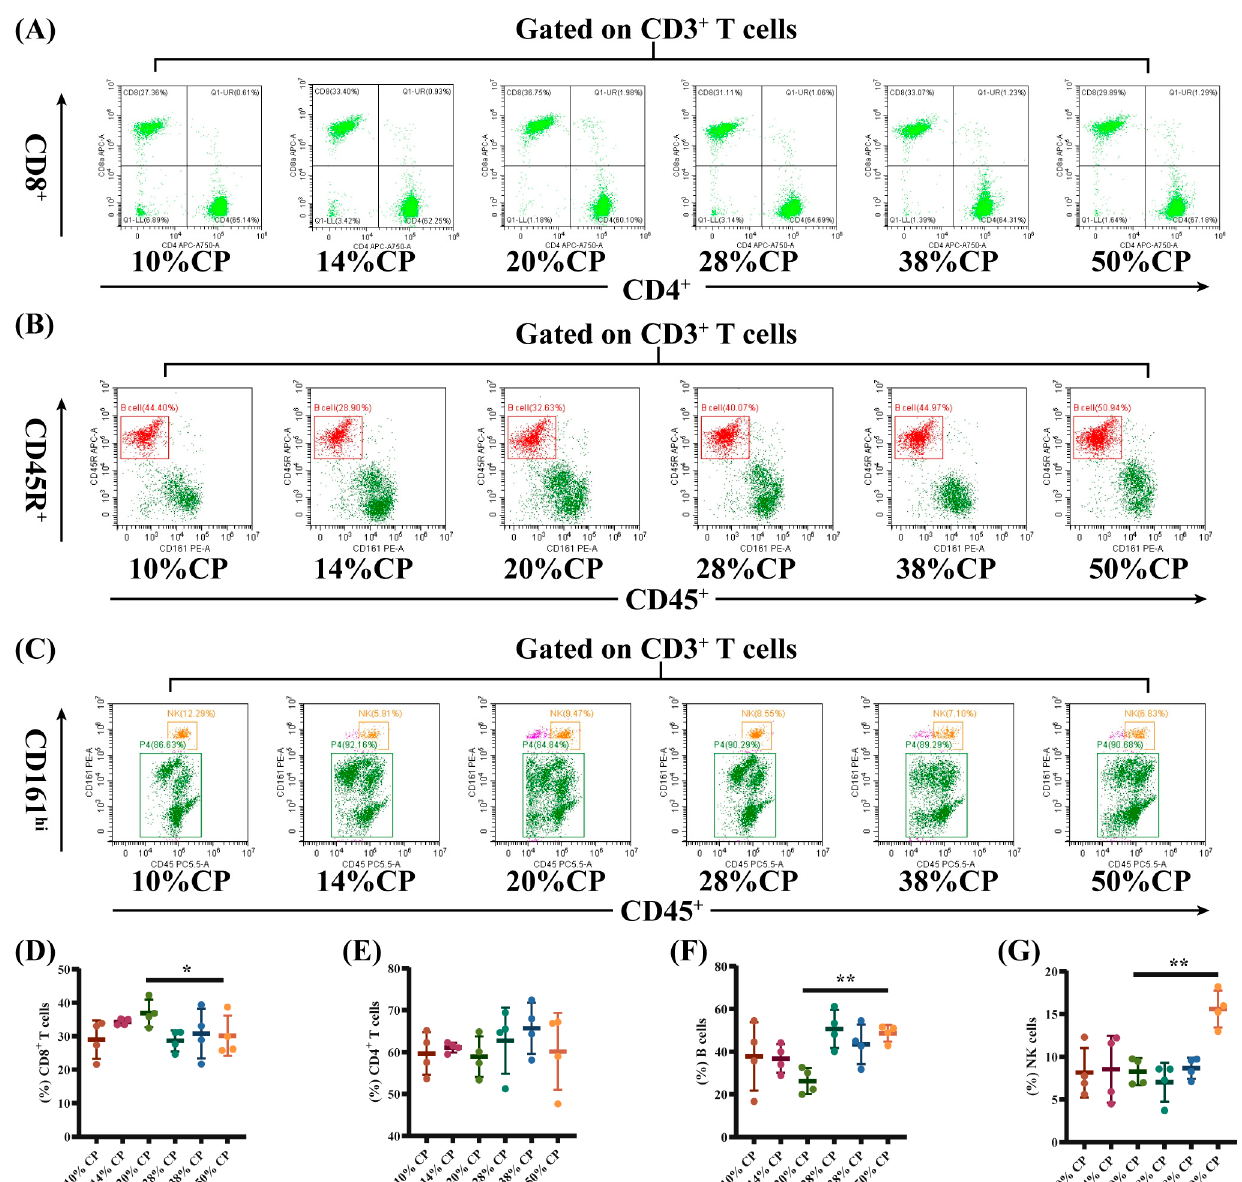
Figure 3. Effects of feeding diets with different protein concentrations for 6 weeks on the lymphocyte subsets in the peripheral blood of SD rats ( n = 4). PBLS were stained with appropriate antibodies and isotype controls and initially gated on CD3 + T cells. Dot plots depicting the approach to gating on ( A ) CD4 + and CD8 + T cells; ( B ) B cells; and ( C ) NK cells in representative rats fed 10%, 14%, 20% (control), 28%, 38%, and 50% crude protein diets. Percentages of circulating ( D ) CD4 + T cells; ( E ) CD8 + T cells; ( F ) B cells; and ( G ) NK cells in rats fed 10%, 14%, 20% (control), 28%, 38%, and 50% crude protein diets. * p < 0.05 and ** p < 0.01, compared with the 20% crude protein diet.